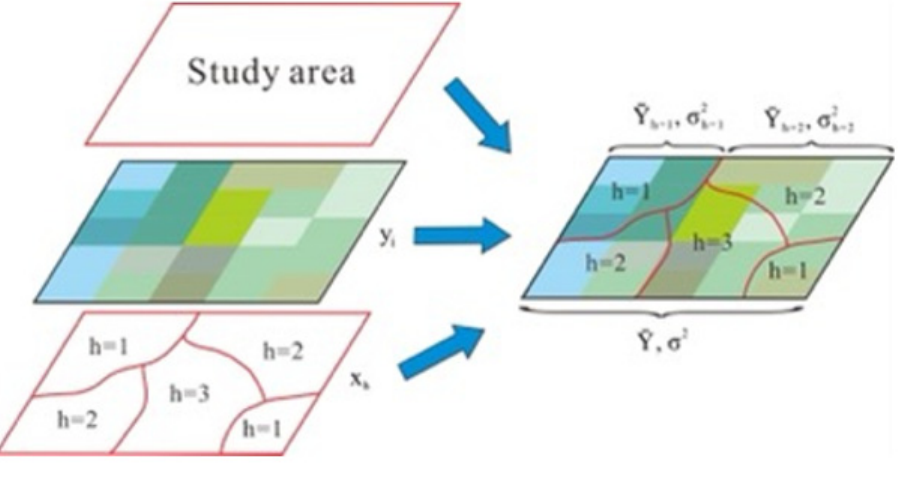
Figure 4. Principles of GeoDetector.